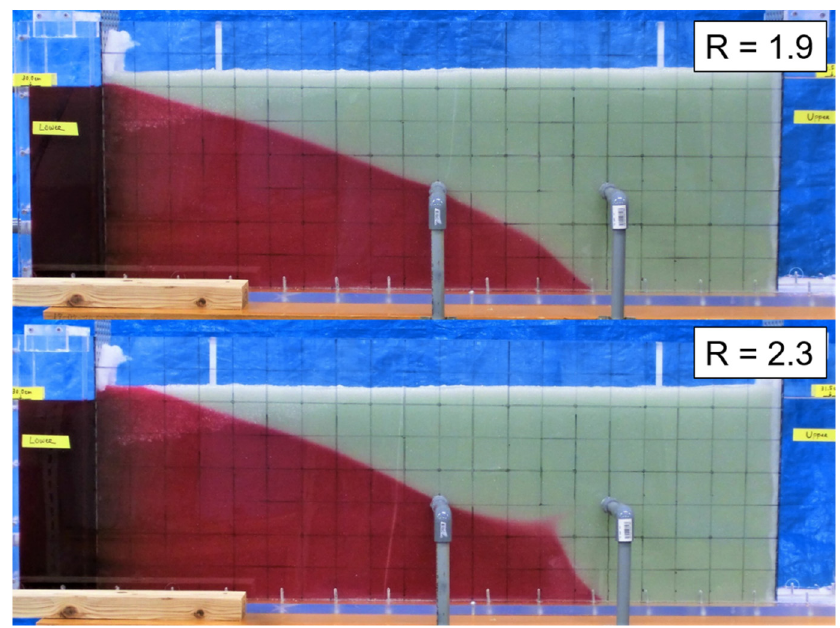
Figure 6. Result of the secondary test. Upconing was observed at R = 2.3, even though it was not observed at R = 1.9.